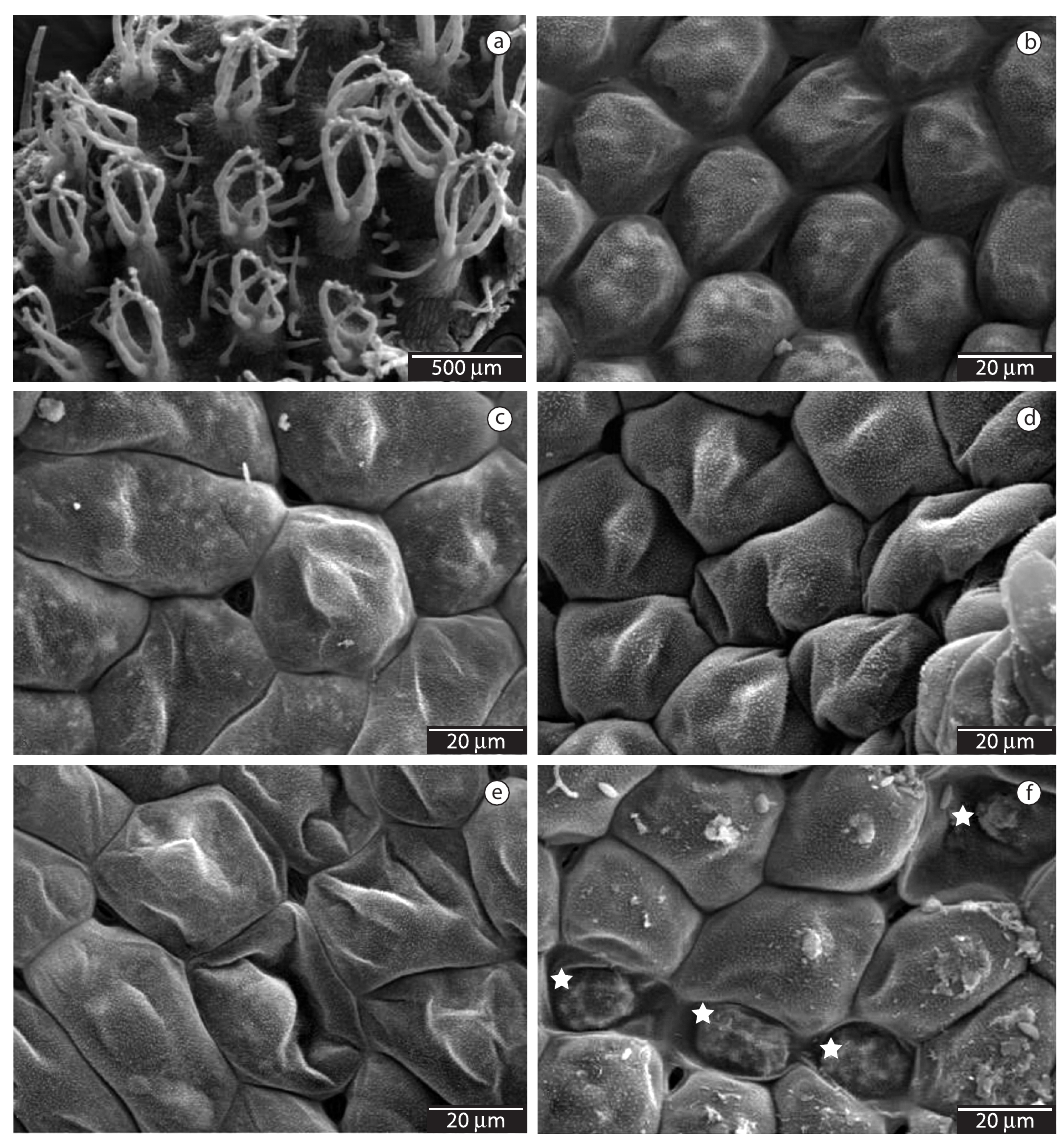
Figure 3. Scanning electron microscopy of adaxial leaf surface of Salvinia auriculata . a) and b) Plant control, c) plant subjected to 100 mM NaCl, d) plant subjected to 200 mM NaCl, e) plant subjected to 100 mM Na subjected to 200 mM Na SO (Stars – highly altered 2 4